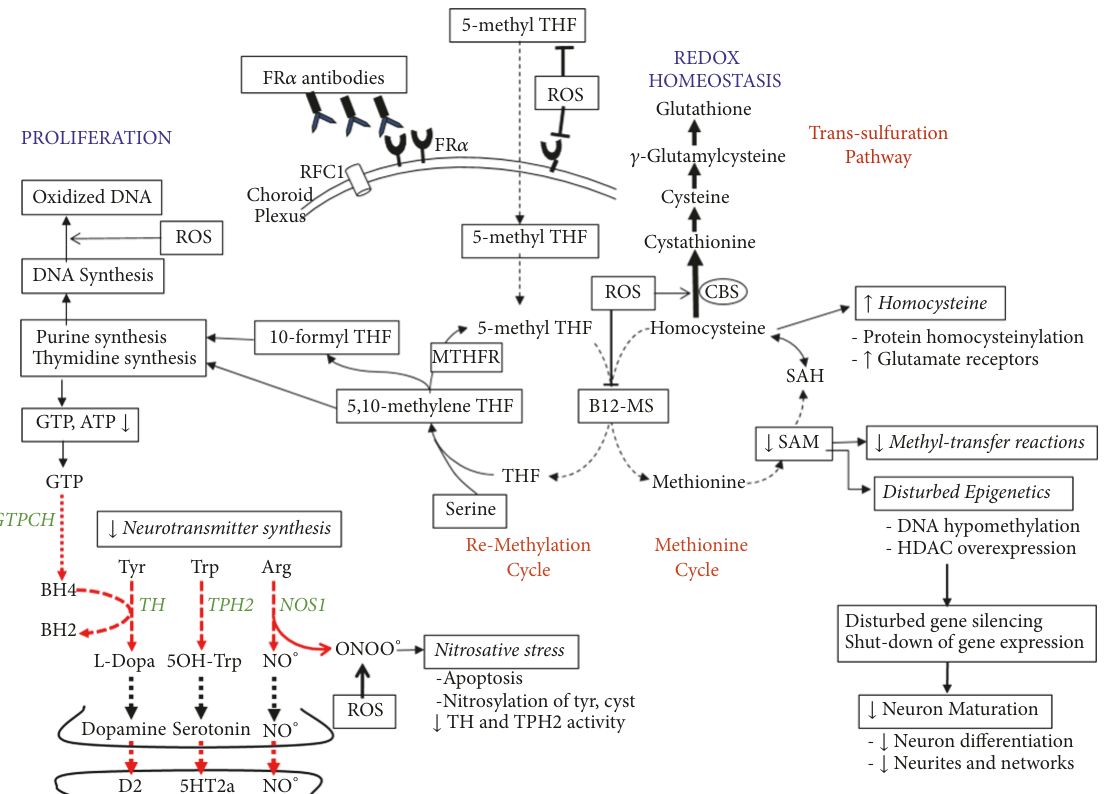
Figure 2: Pathophysiology of autism based on our findings showing the impact of reactive oxygen species (ROS) at different levels of intermediary metabolism and the consequences of brain 5-methyl-tetrahydrofolate (5-methyl THF) deficiency due to FR 𝛼 autoimmunity. ROS inhibits B 12 -methioninesynthase(B 12 -MS)activityand stimulatescystathionine-beta-synthase(CBS) activity,shifting the homocysteine accumulation from the methionine cycle into the transsulfuration pathway with increased production of the natural antioxidant glutathione. Superoxide anions also reactwith NO at the levelof NO-synthase(NOS1) to form peroxynitrite instead of NO, whichpredisposes to apoptosis and nitrosylation of tyrosine and cysteine. Nitrosative stress affects activity of tryptophan- (TPH2) and tyrosine hydroxylases (TH), the rate- limiting enzymes for serotonin and dopamine synthesis. In addition ROS catabolize 5-methyl-THFand impair folate uptake and transcellular transport across the choroid plexus and placental barriers due to interaction with FR 𝛼 and RFC1 folate transporters. FR 𝛼 autoantibodies also impairfolatetransporttothefetusandbrainandpredisposetobrainfolatedeficiencywithreductionofSAMproductionandSAM-dependent methyl-transferreactions,reducedpurineandthymidinesynthesiswithdiminishedGTPand BH4production,whichisthecommoncofactor of the enzymes TH, TPH2 and NOS1. Reduction of the activated methyl-group donor SAM down regulates DNA methylation and affects posttranslational modifications of histones (methylation and trimethylation of histones), thereby impeding the homeostatic balance between gene transcription and silencing. In addition folate deficiency is accompanied by overexpression of histone deacetylases, which further leads to abnormal gene silencing. The shutdown in expression of specific sets of genes will affect neuronal growth, pruning and differentiation. Abbreviations: GTPCH: GTP-cyclohydrolase I; cyst: cysteine; tyr: tyrosine; MTHFR: methylene-tetrahydrofolate reductase; RFC1: